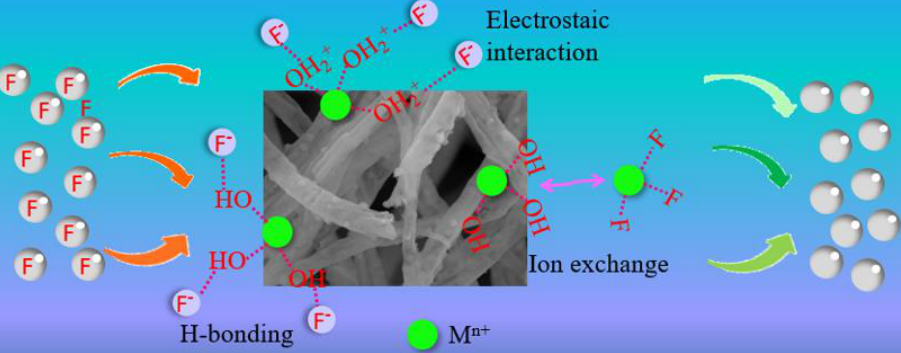
Figure 13. Possible F − adsorption mechanism of LMF11